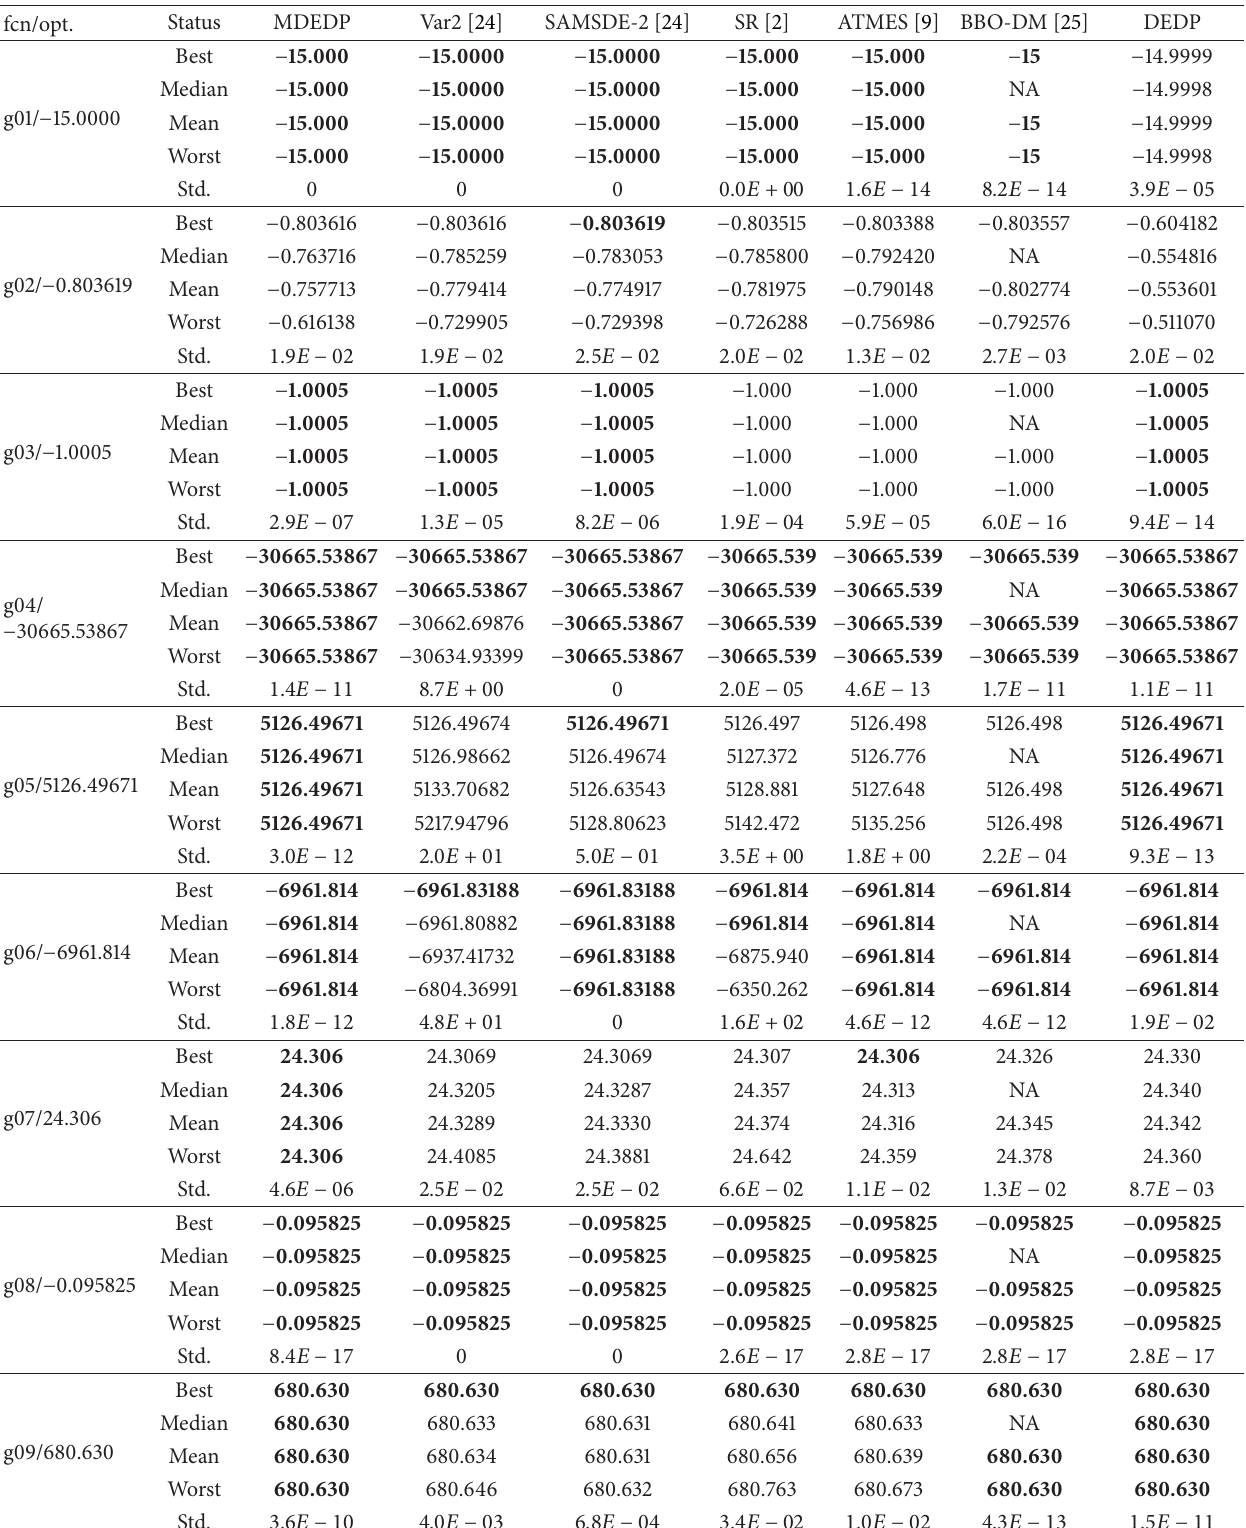
Table1:StatisticalresultsobtainedbyMDEDPover30independentrunsandthecomparisonwithVar2[24],SAMSDE-2[24],SR[2],ATMES [9], and BBO-DM [25]. The result in boldface indicates that the proposed MDEDP obtained the global optimum. The bold-face values mean they are optimal solutions. NA means not available in related